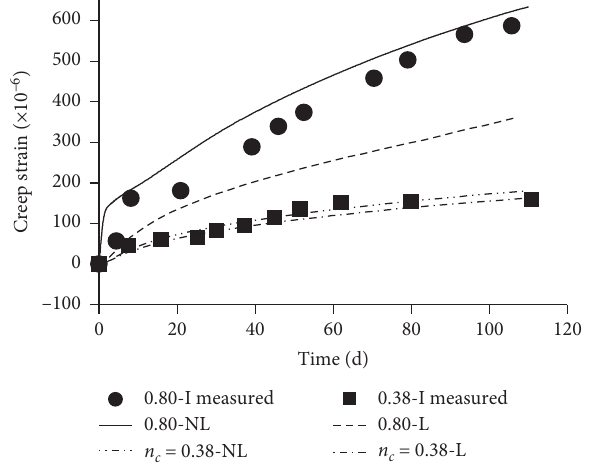
Figure 8: Calculated concrete creep strain curve (Lin